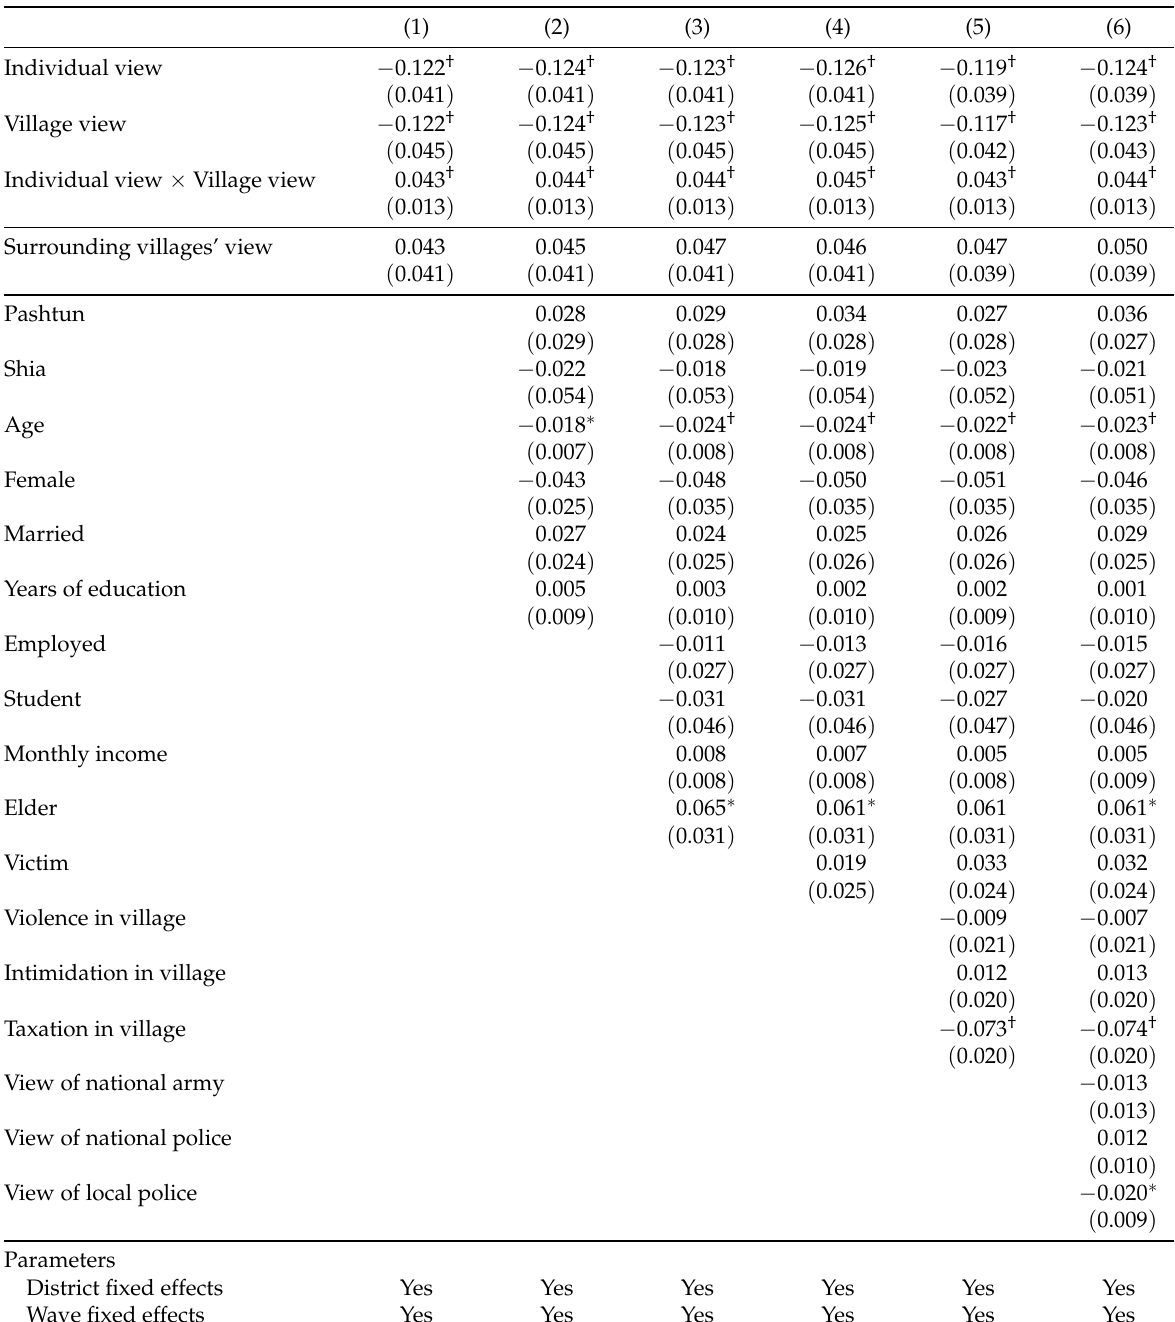
Table 8: Association between individual and village views of the Taliban and whether individuals report wrongdoing, accounting for village